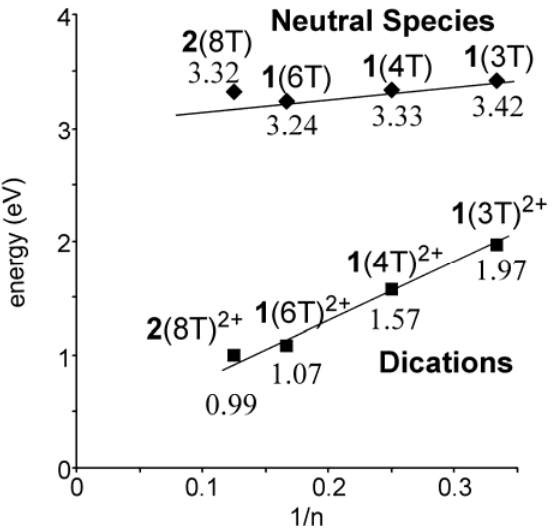
Figure 6. Correlation of the longest wavelength absorption of 1 (nT) (n = 3, 4, 6), 2 (8T), 1 (nT) 2+ (n = 3, 4, 6) and 2 (8T) 2+